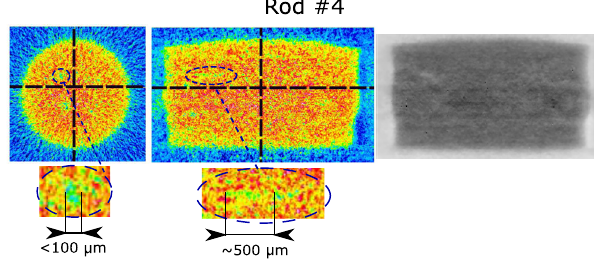
FIG. 11. Zoom-in images of the neutron tomography corre- sponding to rod No. 4 (the most loaded one according to simulations presented in Figs. 6 and 7). Voids with a size of a few tens of micrometers in radius by 500 μ m can be identified.